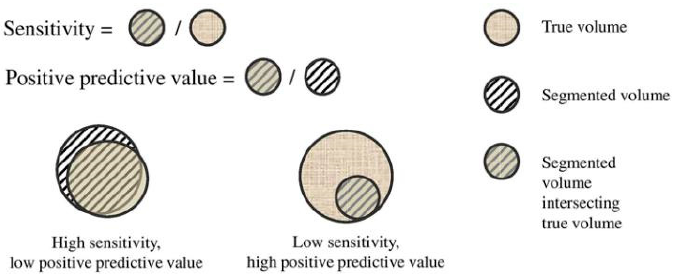
Figure A2. Graphical ilustration of sensitivity (Sen.) and positive predictive value (PPV).